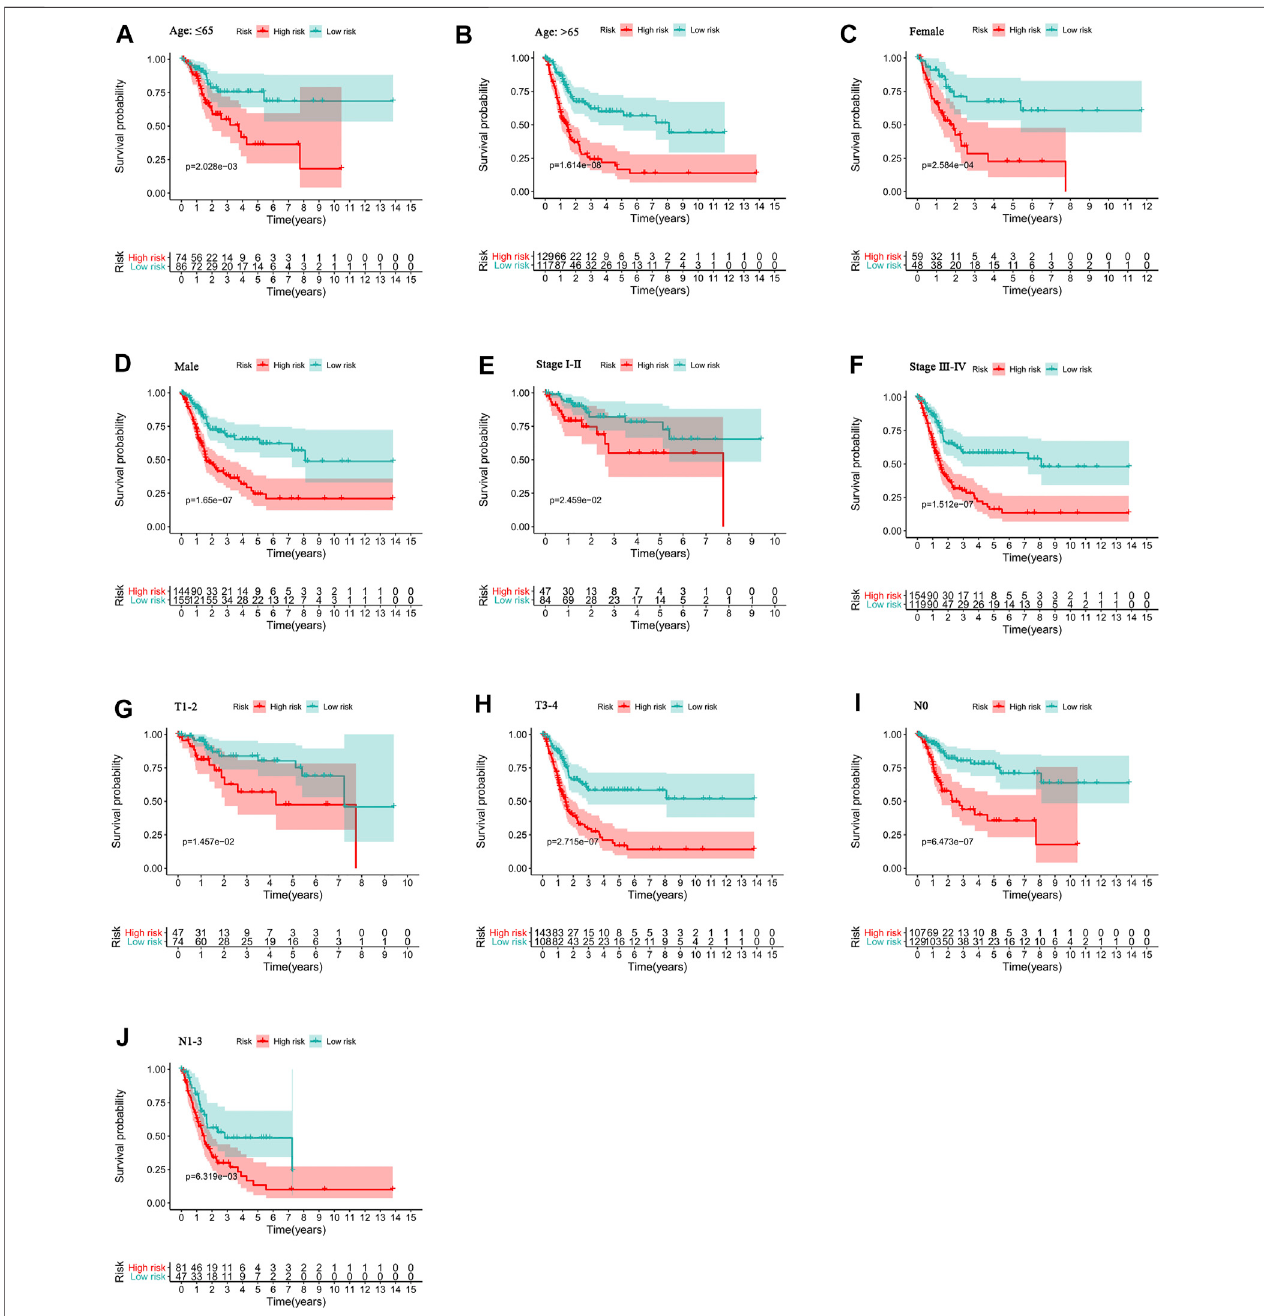
FIGURE7| Kaplan-Meier survivalcurvesofhigh- andlow-riskgroups amongpatientssortedaccordingtodifferentclinicopathologicalvariables. (A-B) Age. (C-D) Sex. (E-F) Stage. (G-H) T stage. (I-J) N stage. T, tumor; N, lymph node.